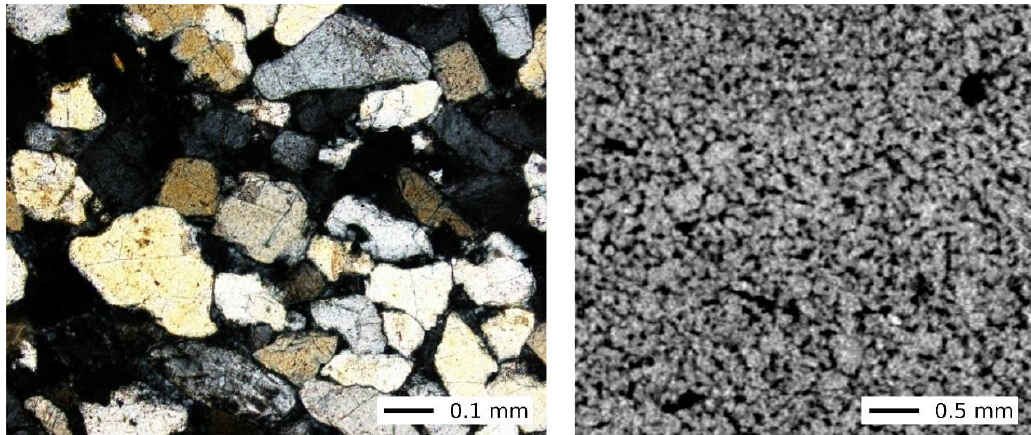
Figure 1. The microtexture of the Mšené sandstone— cross polarizers (XPL) optical microscopy in transmitted light (left), X-ray micro-CT of a dry sample (right).